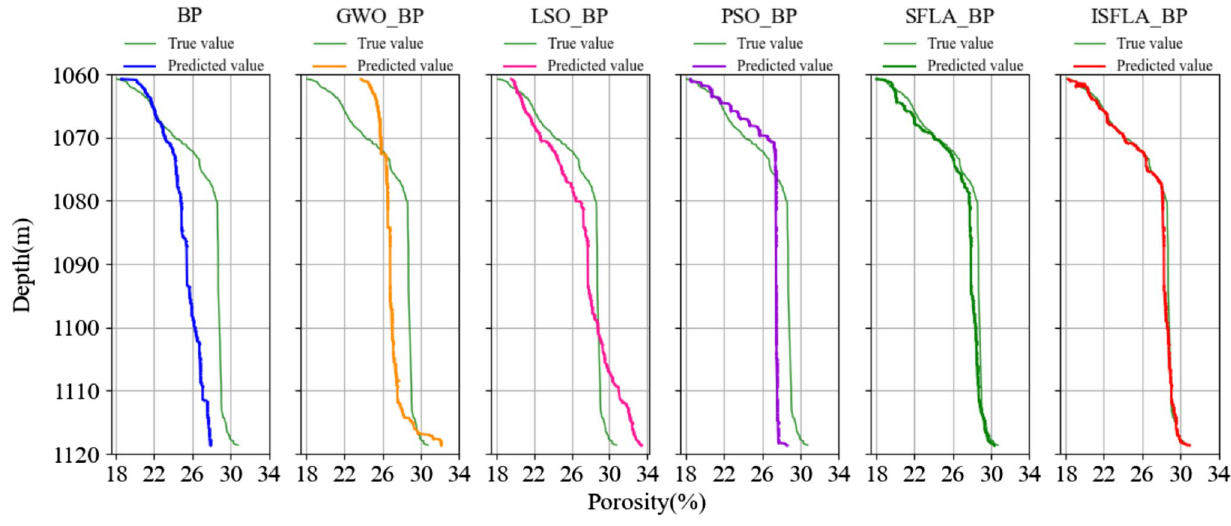
Fig. 9 Comparison of predicted values and true